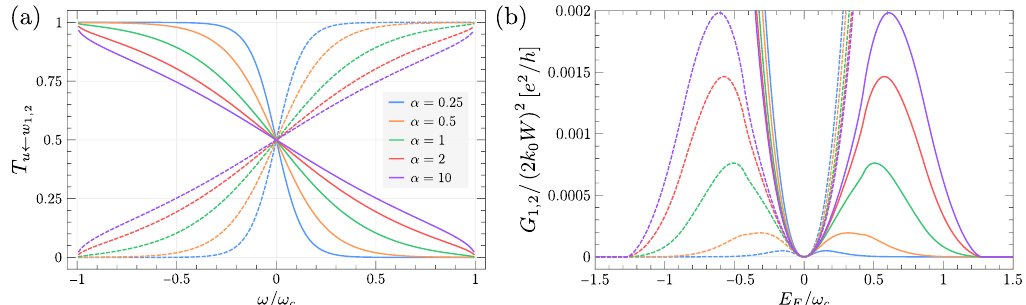
Figure 6: (a) T (solid) and T (dashed) for k ⊥ = ( ± k u ← w 1 u ← w 2 [ 1 + tanh ( α z )] where ω lattice model for the tilt profile V ( z ) = v F in the type-II region. (b) Zero-bias differential conductance at zero temperature G (solid) and G (dashed) for the same parameters as in 2